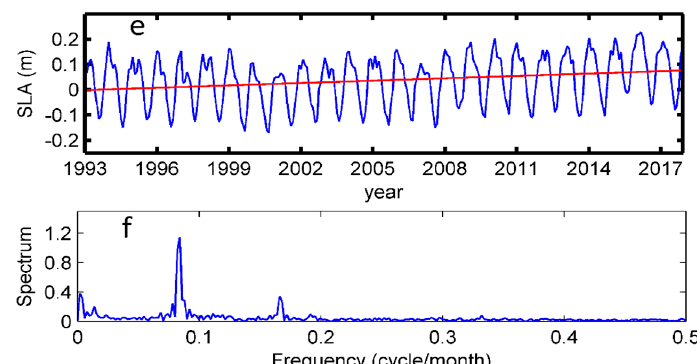
Figure 2. The mean sea level anomaly (SLA) pattern for the RS and GA during the winter, spring, summer, and autumn seasons ( a – d ) from 1993–2017. The time series of SLA with trend in red line for all area ( e ) and the spectral analysis of the time series ( f ).